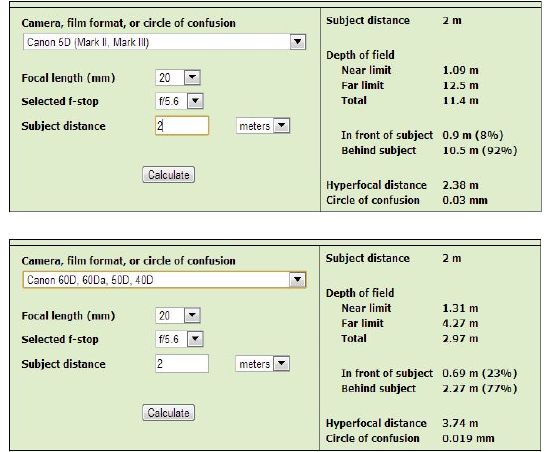
Figure 7 Comparison between the DOF of a full frame and an ASP-C camera coupled with the same lens, taking images 2 m far from the object. For the same relative circle of confusion (8.5e-4) the DOF changes from 11.4m to 2.97m.